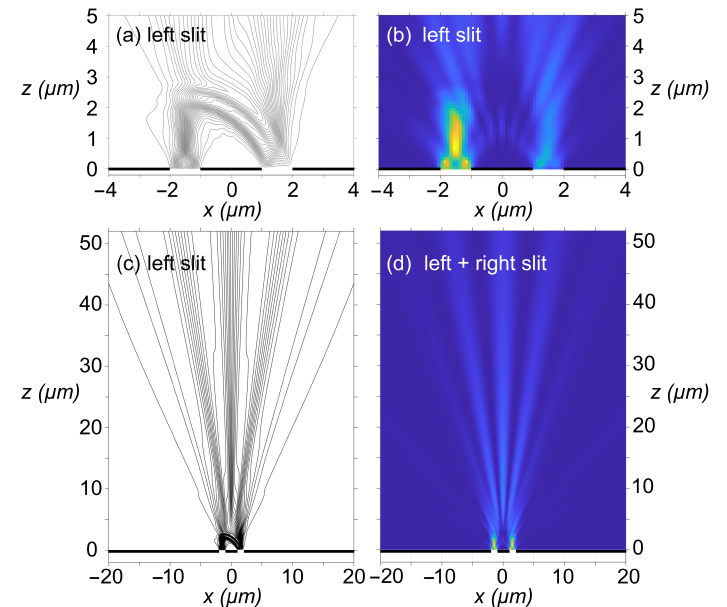
Figure 6. In ( a ) and ( c ), virtual trajectories in the ( x , z ) plane are shown that are determined as the spatial trace formed by the endpoints of particle worldlines as a function of τ . Only particle worldlines passing through the left slit are plotted (right slit is simply mirrored). In ( a ), a close-up is shown of the near field, illustrating that part of the particle worldlines originating from the left slit cross over to the region near the right slit before fanning out over all interference orders in the far field, shown in ( c ). In ( b ) the density of particle worldlines corresponding to ( a ) is plotted. In ( d ), the density distribution of particle worldlines with contributions from both the left and the right slit is shown, which accurately reproduces the prediction of quantum mechanics in the far